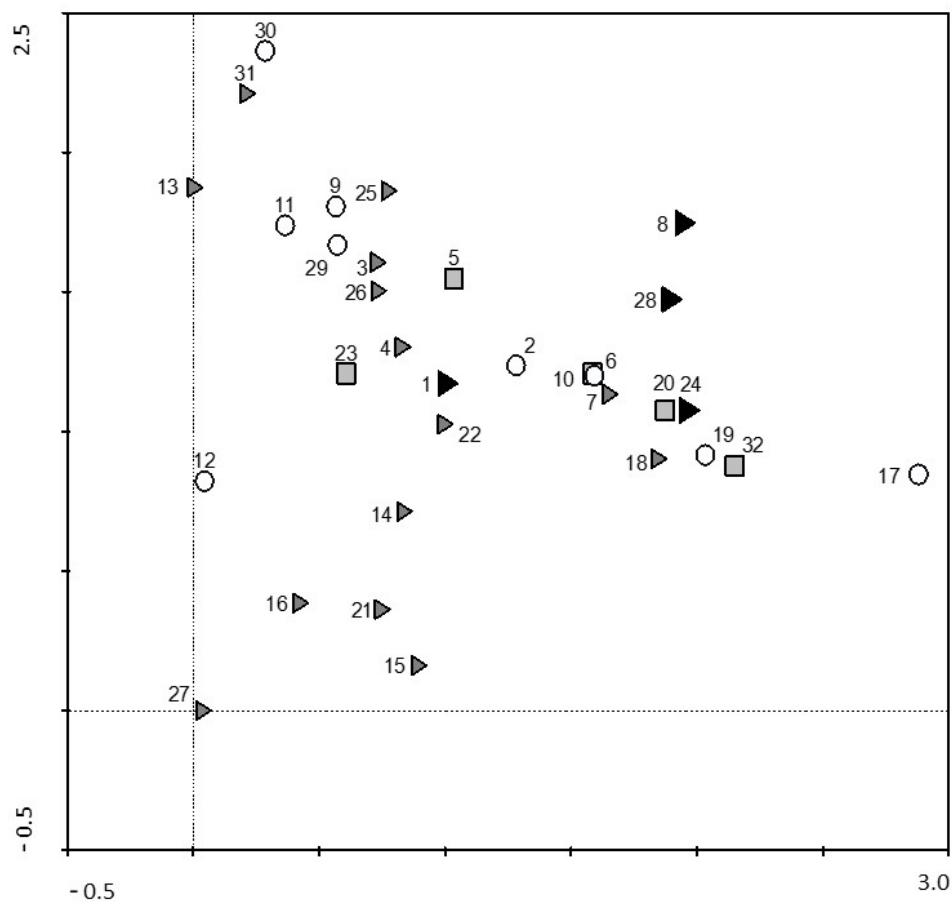
Figure 6. Detrended correspondence analysis ordination diagram showing the similarity of the macrophyte stands in different sites. Numbers from 1 to 32 indicate the location of the site with respect to the river Drava flow direction. Different symbols indicate different water bodies (white circles—ponds, light grey squares—oxbows, small dark grey right triangles—side channels, black right triangle—sample sites in the main channel of the river